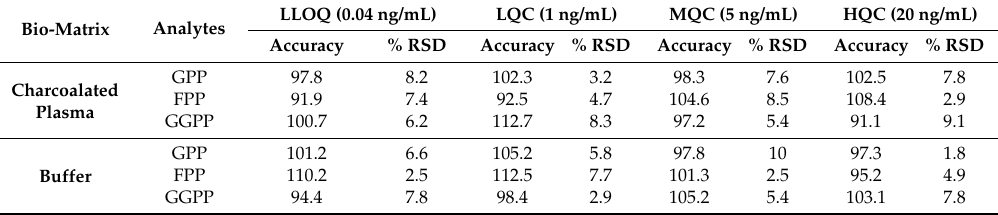
Table 2. Inter-day precision (% RSD) and accuracy for GPP, FPP and GGPP in human plasma and buffer solution.